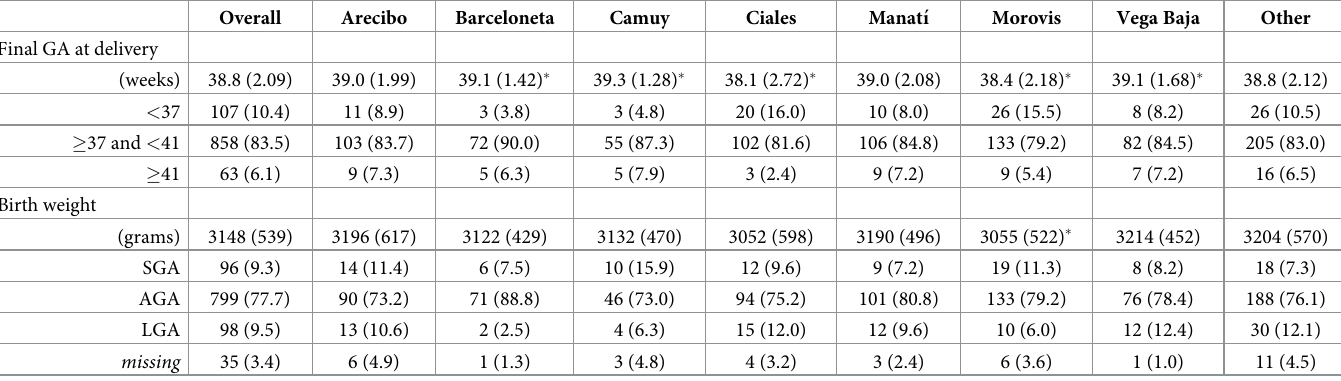
Table 2. Characteristics of pregnancies by municipality of residence: Mean (SD) or n